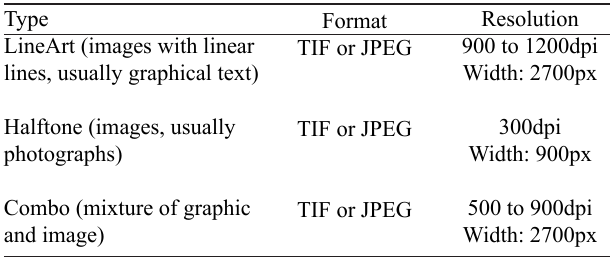
Table 1. Specifications of PubMed Central for images and graphics [1]